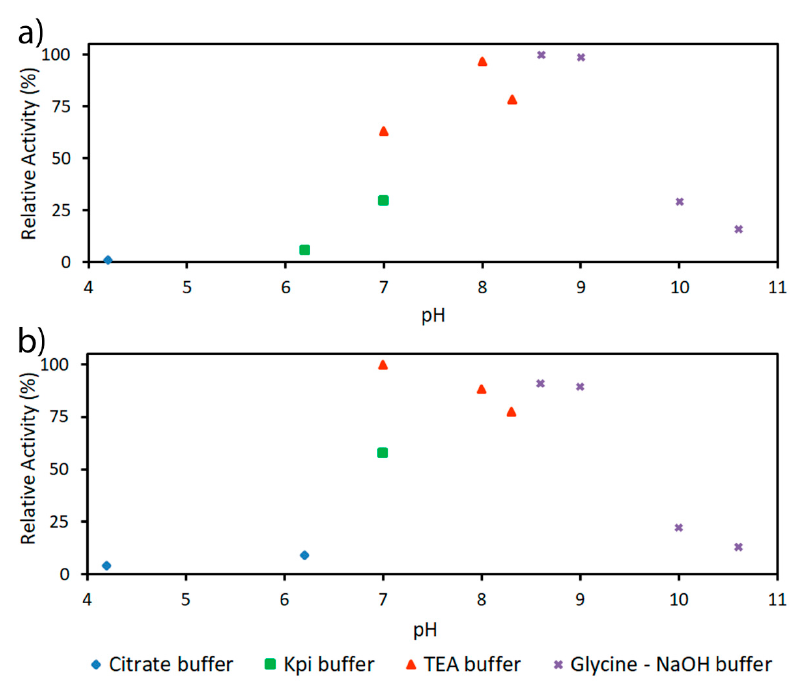
Figure 2. Overview of relative activity of ( a ) Pa DERA and ( b ) Ec DERA at different pH values. The enzyme assay was performed using the standard assay procedure in the following buffers (100 mM): (1) Citrate (pH 4.2, 5.0 and 6.2), (2) KPi (pH 6.2, 7.0 and 8.2), (3) TEA (pH 7.0, 8.0 and 8.3) and (4)